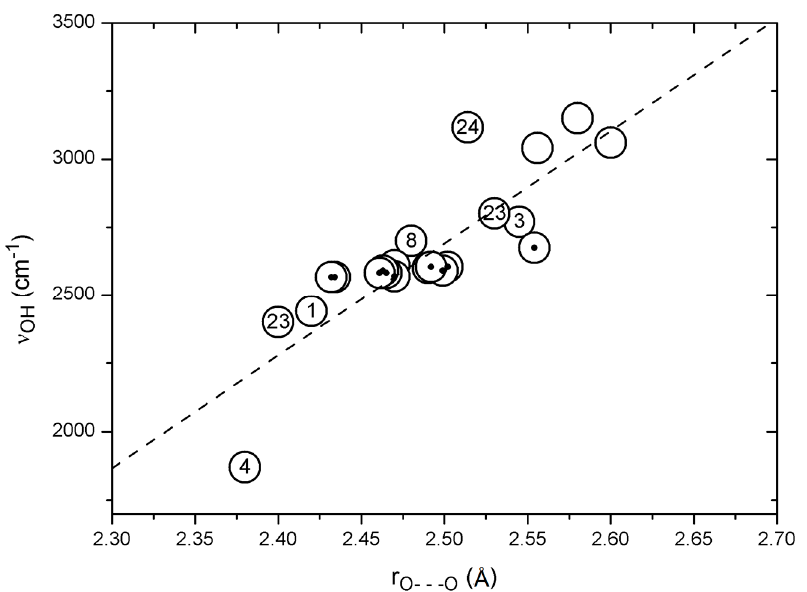
Figure 4. Correlation between observed OH stretching wavenumbers and observed O···O distances (see text). Points from Bertolasi et al. [123] are marked with dots. The correlation line is Y = − 7616 + 4122.9 · X (22 pts: R = 0.83, SD = 161 cm − 1 ).